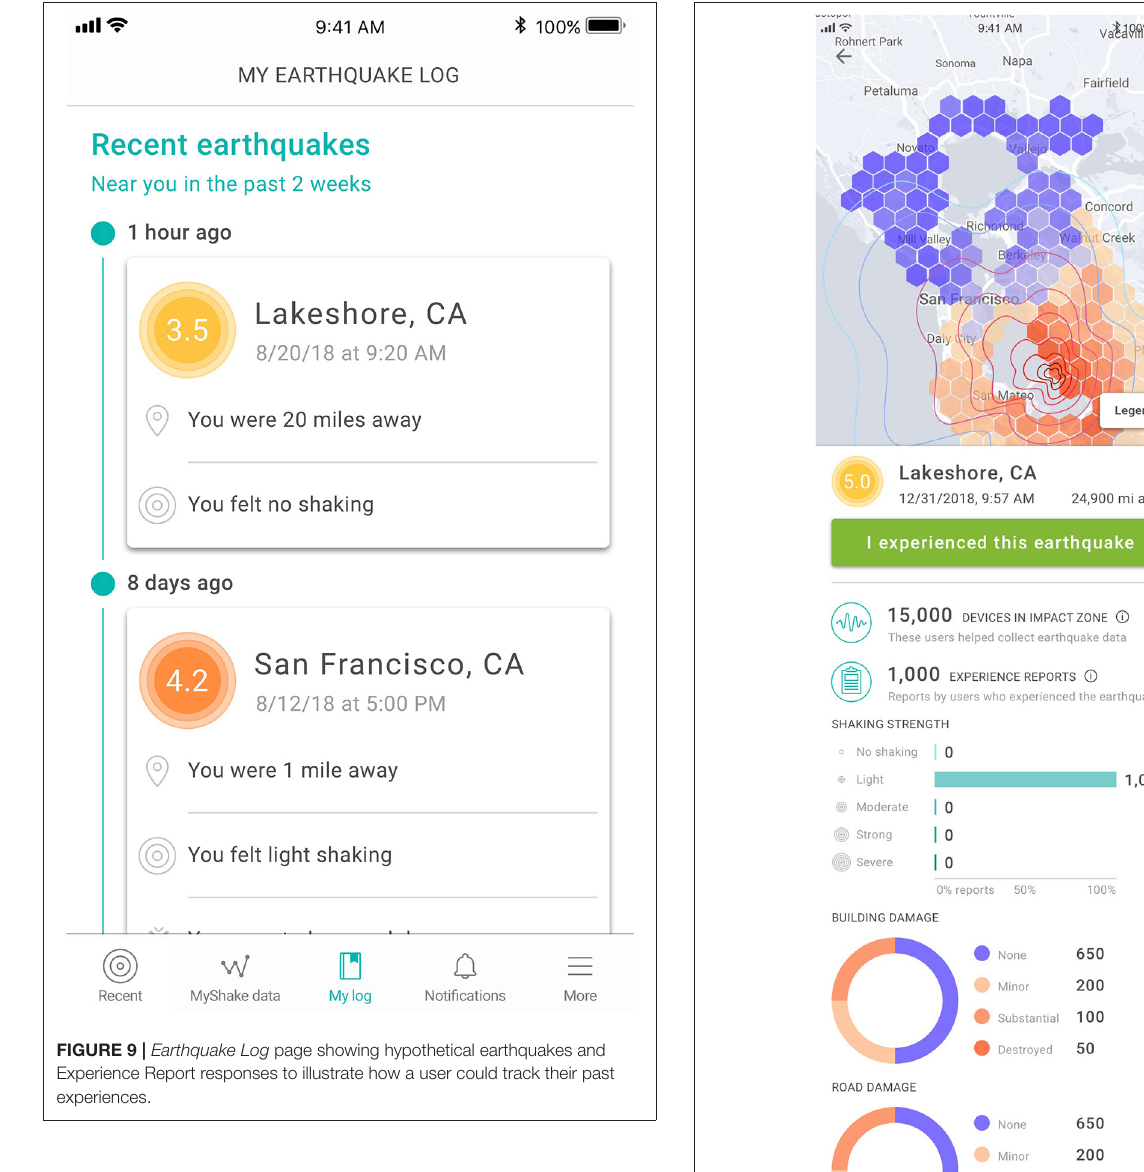
Frontiers in Earth Science |